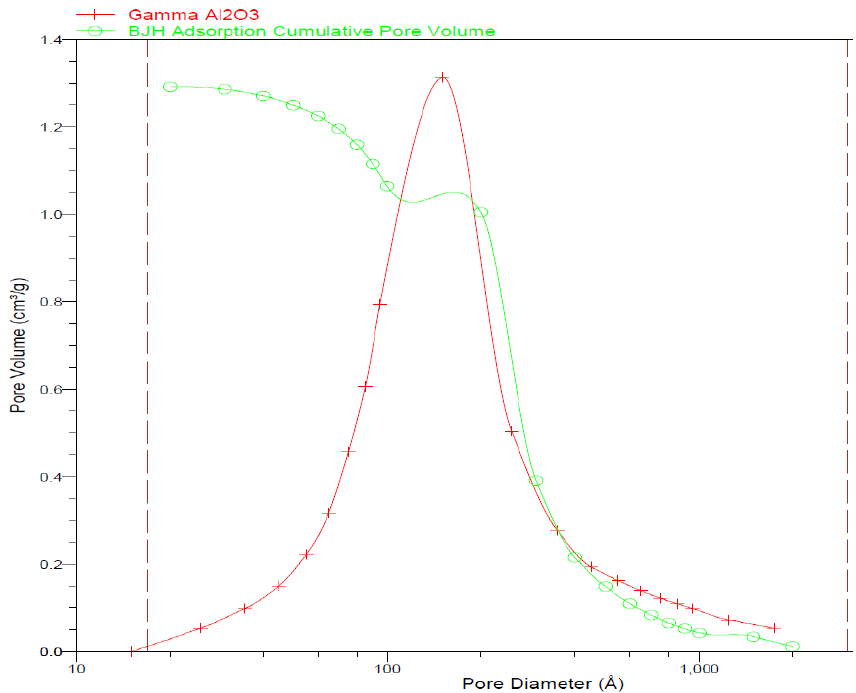
Figure 4. Pore volume of tested γ-alumina as a function of pore diameter.